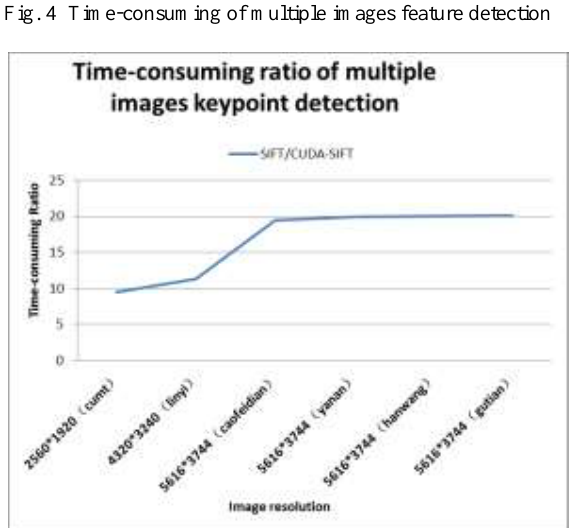
Fig. 5 Time-consuming ratio of multiple images feature detection